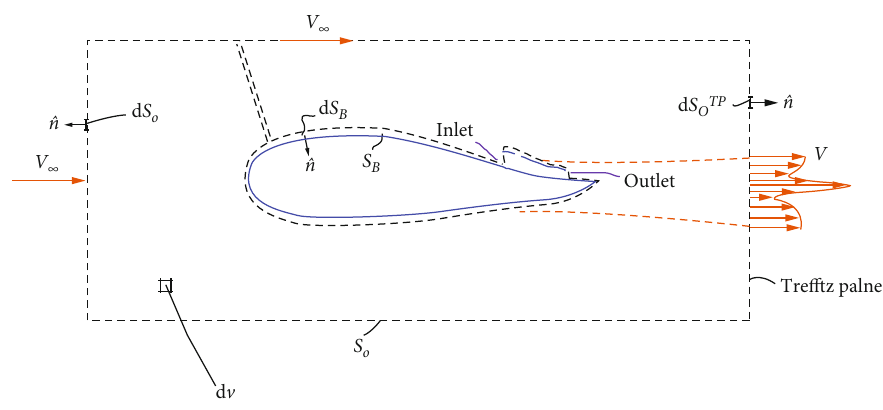
Figure 1: 2D slice of the 3D control volume used for the power balance